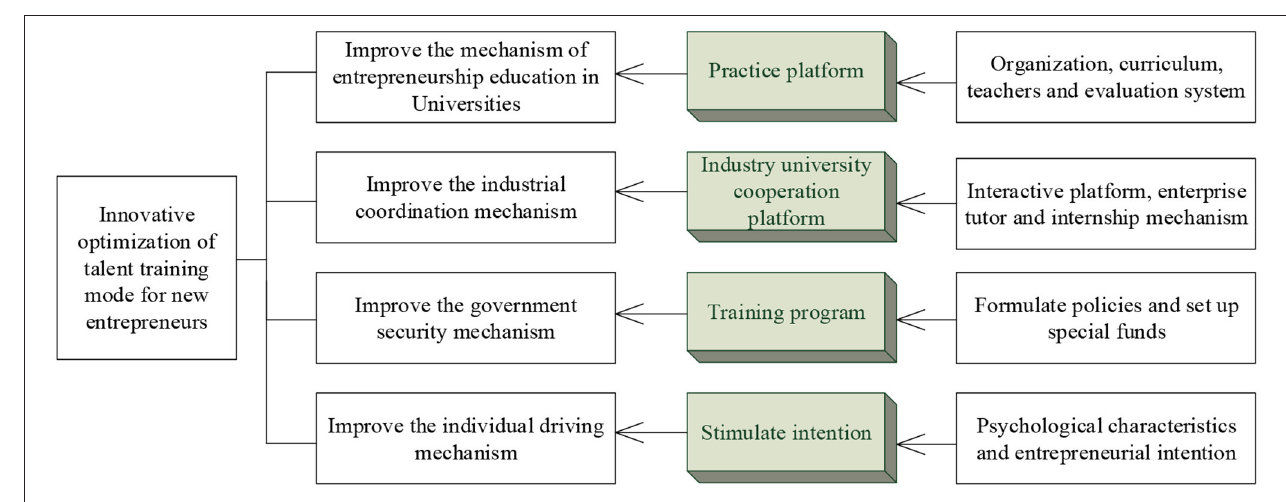
FIGURE 9 | Optimization of the innovative training mechanism of new entrepreneurial talents.